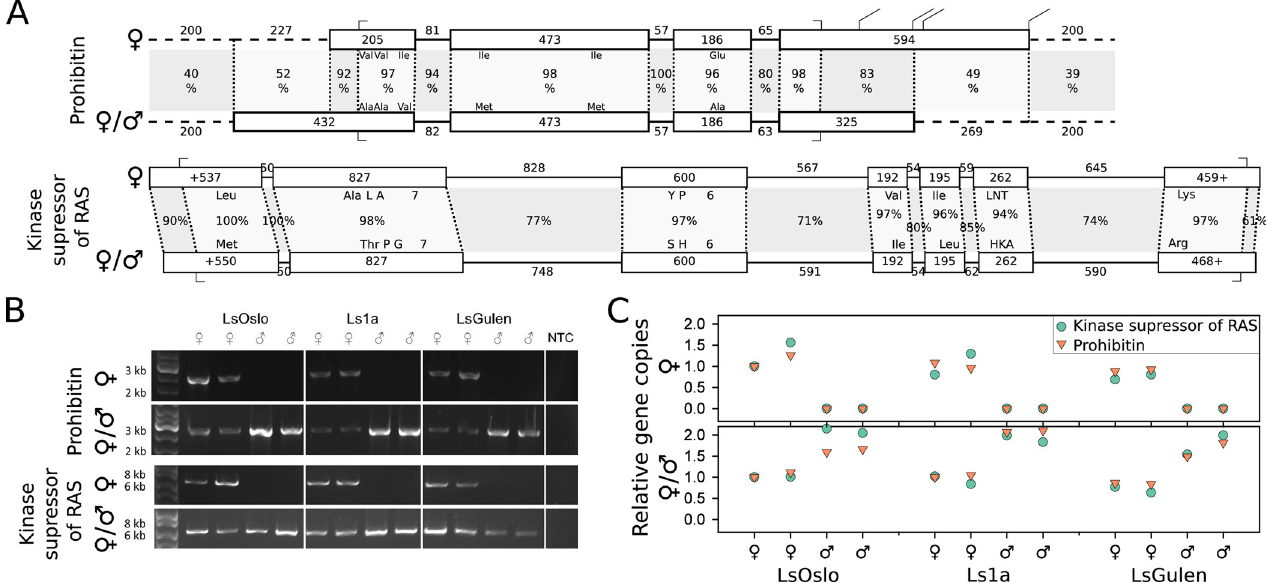
Fig 1. Sex-specific gene variants. A. Exon-intron-structure of the female-specific and the unisex variants of prohibitin-2 and kinase suppressor of Ras 2. Boxes mark exons, lines introns. Sizes of the structures represent the number of basepairs given over (intron) or in (exon) the structure. Shadowed areas between the two variants have been aligned and the identity (%) calculated (numbers in the middle). Amino acid changes are shown by the respective (one-letter) amino acid code at the respective sites in the exons. In the case of a high number of amino acid changes in one region, only the number of amino acid changes at that site is given. Dashed lines represent regions upstream and downstream of the UTRs. Start and Stop codons are marked. B. Presence of the female-specific and the unisex variants of prohibitin-2 and kinase suppressor of Ras 2 in the genome of males and females of different salmon lice strains as determined by PCR. C. Relative gene copy numbers of the female-specific and the unisex variants of prohibitin-2 and kinase suppressor of Ras 2 in the genome of males and females of different salmon louse strains as determined by qPCR.